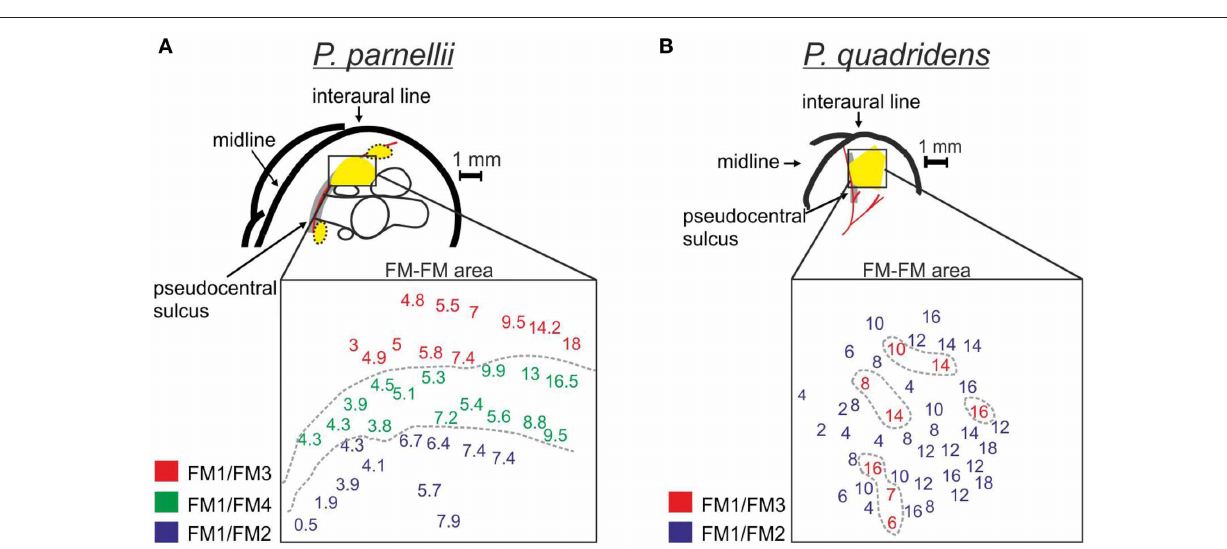
FIGURE 2 | Topographic organization of the FM/FM area of (A) P. parnellii and (B) P. quadridens . In each species, schematic representations of the brain are given. In the schematic brain representations, prominent landmarks and blood vessels are indicated. The yellow areas indicate cortical regions dominated by delay-tuned neurons. Note that in the dorsal auditory cortex of both species, close to the pseudocentral sulcus, there are large areas dedicated to the processing of call-echo delay. In each species, a detailed map of the FM/FM area is given. The data from P. parnellii is from one specimen [modified from Hagemann et al. (2011)]. The data from